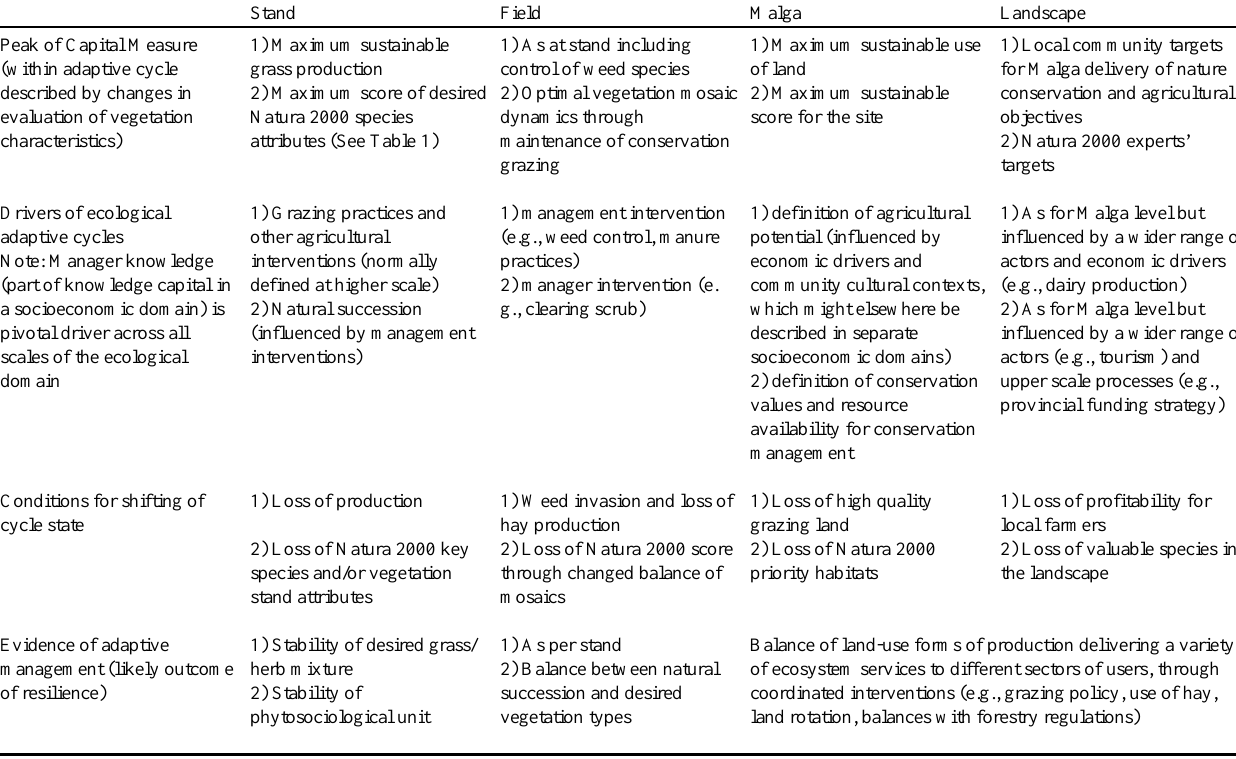
Table 2 . Peaks of capital, drivers, shifting states, and evidence of resilience across scales in the Malga ecosystem. Stand Field Malga